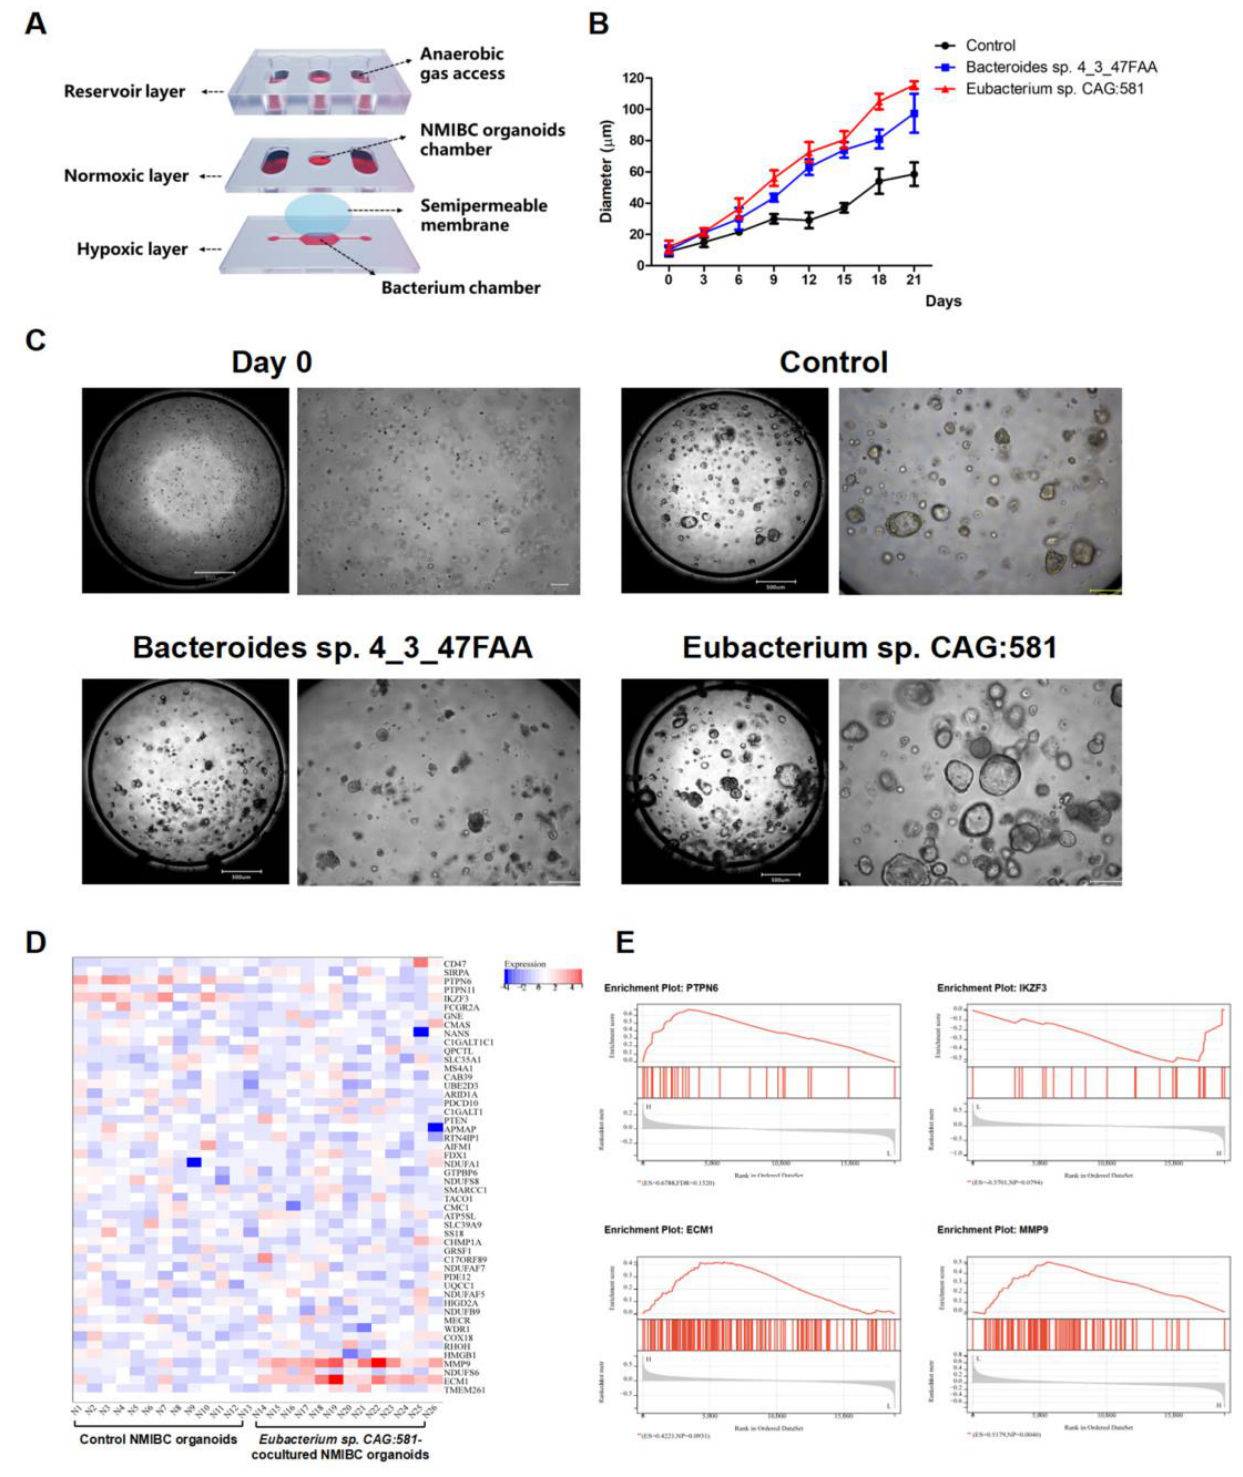
Figure 2. The coculture of Eubacterium sp. CAG:581 promoted the growth of NMIBC organoids. ( A ) Schematic diagram of the coculture system of NMIBC organoids and anaerobic urine microbiota using the two-chambers chip. Each chip had a reservoir layer on the top, a 3D implanting hole in the middle, and an anaerobic culture slide underneath. ( B ) Growth curve of the NMIBC organoids cocultured with Eubacterium sp. CAG:581 (10 6 cfu per chip) and Bacteroides sp. 4_3_47FAA (10 6 cfu per chip). The results are presented as mean ± SD, n = 3. ( C ) Bright-field images showing the repre- sentative NMIBC organoid sizes on Day 0 and the Eubacterium sp. CAG:581 coculture group, the Bacteroides sp. 4_3_47FAA coculture group, and the NMIBC control group on Day 21. Scale bars, 1000 μm (left panels) and 10 μm (right panels). ( D ) Heatmap of DEGs of the Eubacterium sp. CAG:581 coculture group as compared with the NMIBC control group on Day 21. Gene copy numbers are transformed as log2 ratios per gene (blue, decrease; red, increase). Gene expression profiling analy- sis was used to identify the potentially upregulated ECM1 and MMP9, as well as the downregulated PTPN6 and IKZF3 (|log2(Fold change)| > 1 and p -value < 0.05). ( E ) The Gene set enrichment analysis (GSEA) plot in the Eubacterium sp. CAG:581 coculture group versus the NMIBC control group. The GSEA algorithm was used to evaluate the statistical significance of ECM1, MMP9, PTPN6, and IKZF3, according to the normalized enrichment scores (NES). These values were assigned to each gene and set after normalization across all analyzed gene sets.